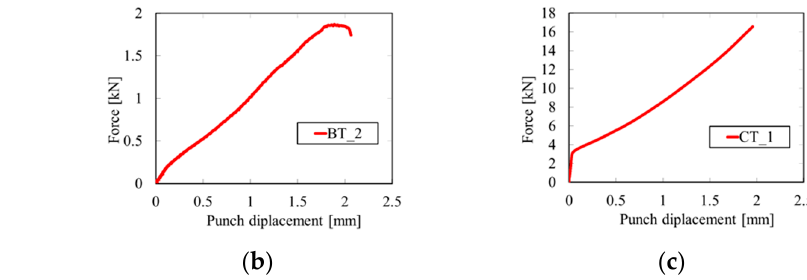
Figure 13. ( a ) Engineering stress-strain curves of different sample geometries and orientations, ( b )